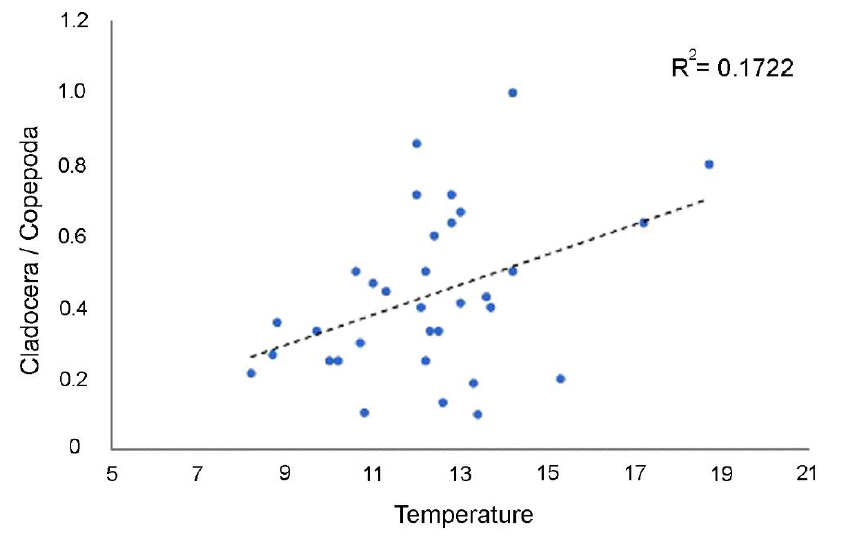
Figure 3. Relationship between temperature of water, measured at sampling sites, and the Cladoc- era/Copepoda ratio.